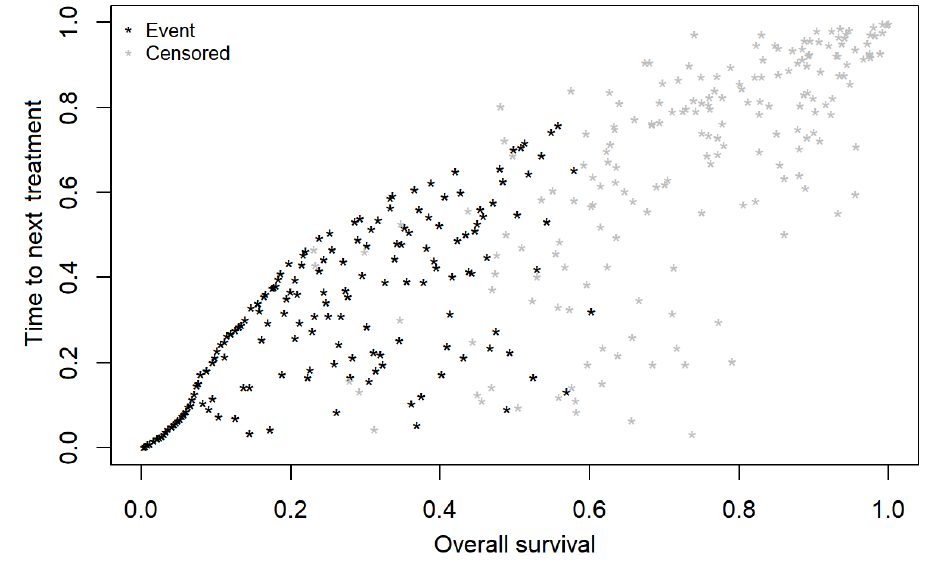
Figure 1. Bivariate copula plot depicting correlation between real-world overall survival (rwOS) and real-world time to next treatment (rwTtNT) of patients with advanced melanoma treated with first-line pembrolizumab.